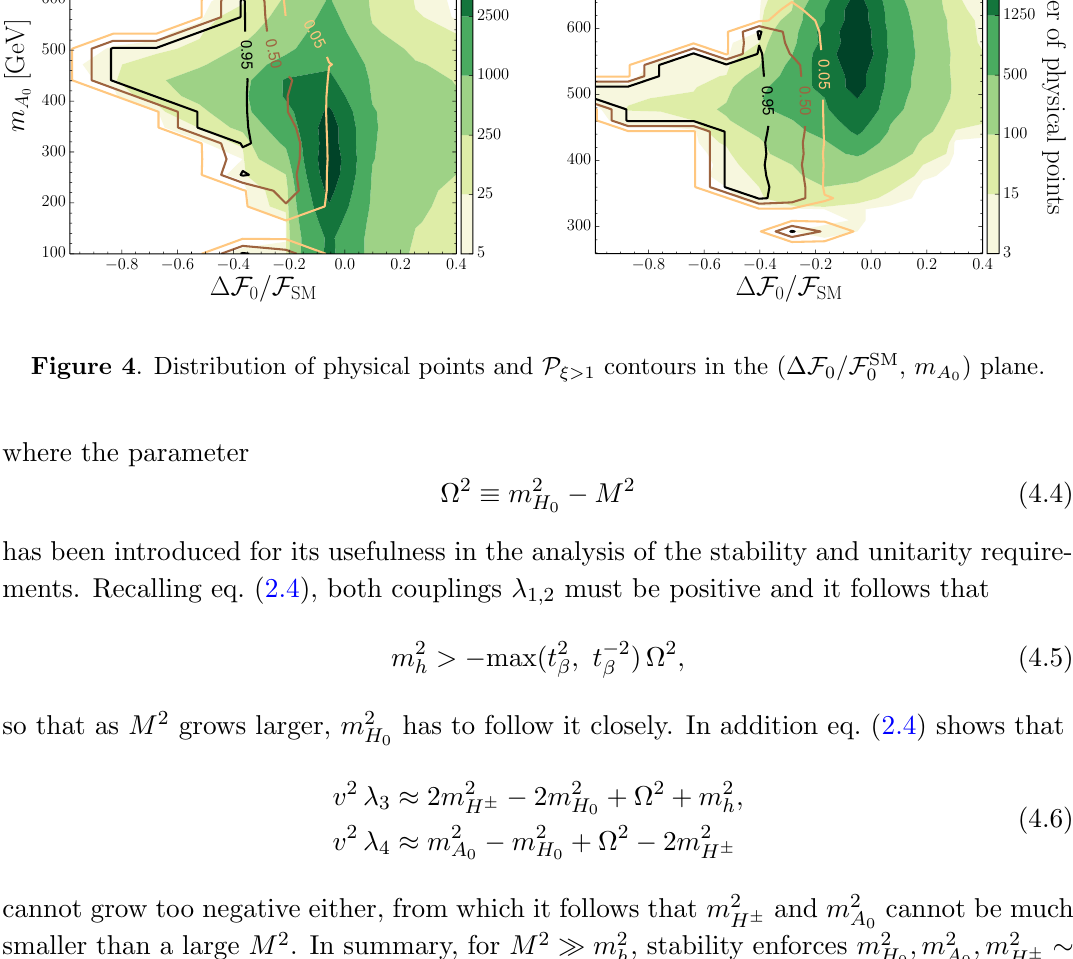
contours in the ((cid:1) P (cid:24)> 1